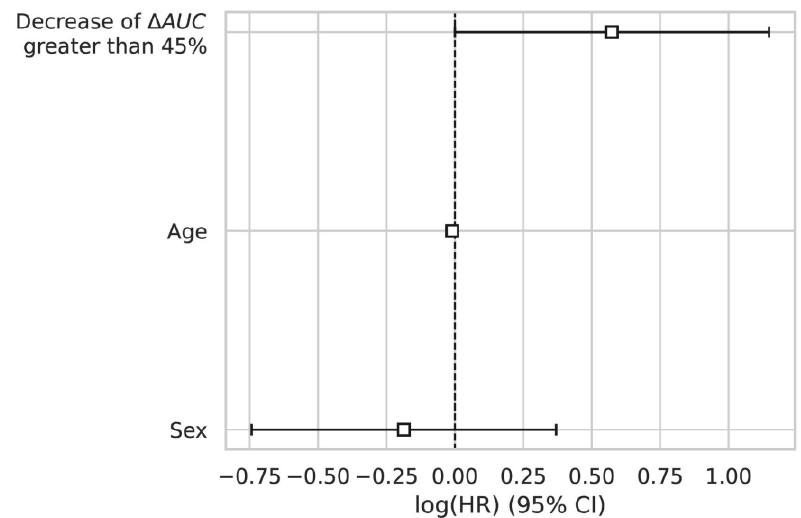
Figure 7. The log hazard ratio of each parameter included in a Cox model. Covariates studied were age, sex, and AUC decrease between baseline and D21 greater than 45%. Only the latter was significantly correlated to survival (HR = 1.75; p -value = 0.05).